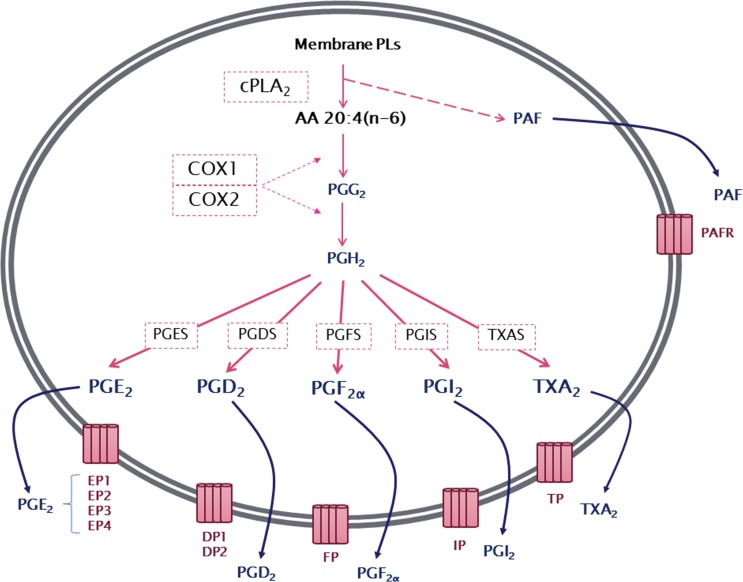
General overview of series-2 prostanoid biosynthesis. After being released from membrane phospholipids (PLs) by the action of cytosolic phospholipase A2 (cPLA2), arachidonic acid is converted by cyclooxygenase 1 or 2 (COX1 or COX2) to an unstable intermediate, prostaglandin H2 (PGH2), which is rapidly converted to the PGs PGE2, PGD2, PGF2α, PGI2, and thromboxane A2 by their specific synthases. Membrane PL cleavage also results in the release of lysophosphatidylcholine, which can be converted to platelet-activating factor (PAF). Prostanoids, thromboxanes and PAF are then released from the cell and can exert a wide range of actions mediated by binding to their specific G protein-coupled receptors, EP1–4, DP1–2, FP, IP, TP and PAFR.